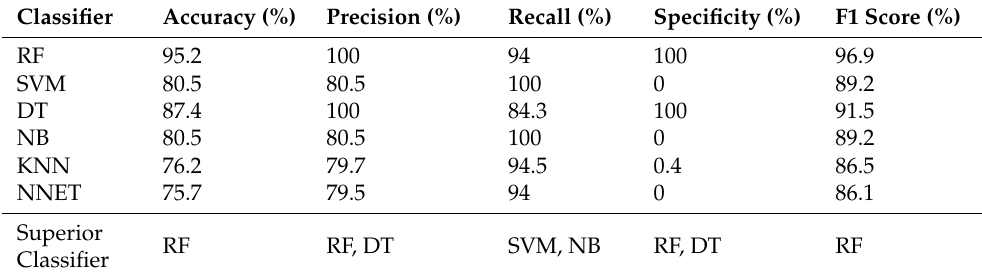
Table 3. Performance comparison of the single-classifier approach on the bagging imputed dataset.